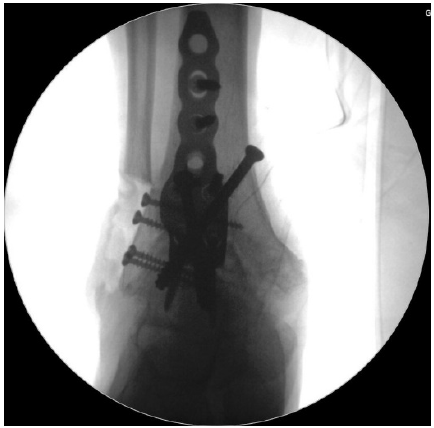
Figure 9. Reduction state and screw positioning without penetration of the subtalar joints were confirmed via fluoroscopy.